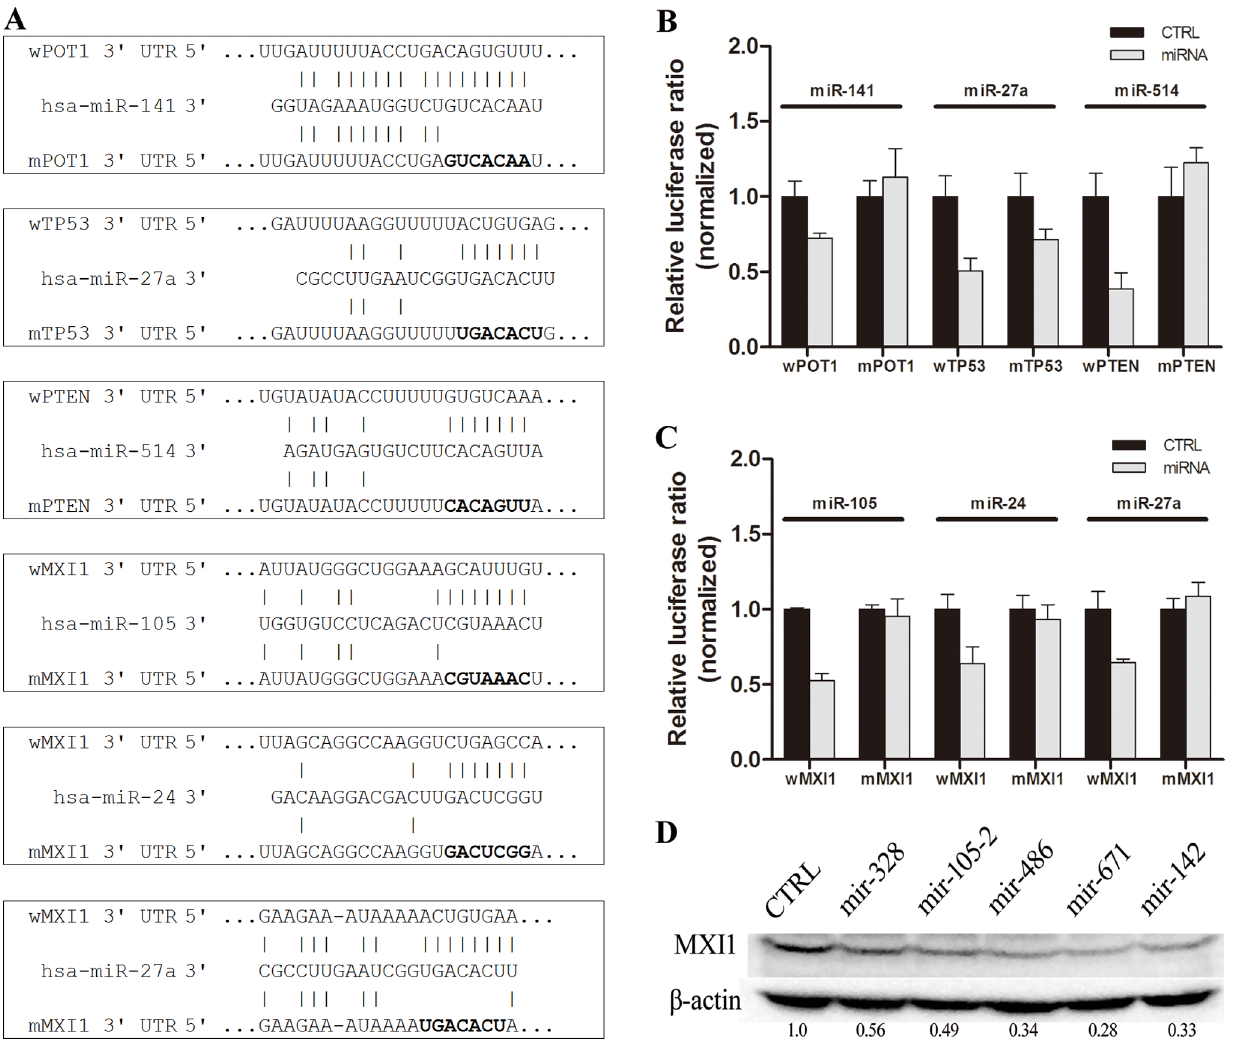
Figure 4. Confirmation of the validated interactions with site mutation and immunoblotting. (A–C) Positive interactions were chosen for mutation analysis of miRNA target sites. The predicted matched sequences between miRNAs and target sites, as well as the seed region chosen for mutant constructs are shown in (A) and the dual-luciferase assay was used to examine the co-transfection of the pre-miRNA and the luciferase reporter containing the cognate target site or mutated cognate target site in POT1 , TP53 and PTEN (B) or in MXI1 (C), in which there was co- transfection of the empty pre-miRNA vector and the same luciferase reporter as a control. (D) Immunoblotting was used to examine the endogeous protein level of target gene MXI1 in 293T cells when the positive miRNAs were transfected into the cells and cultured for 48 h